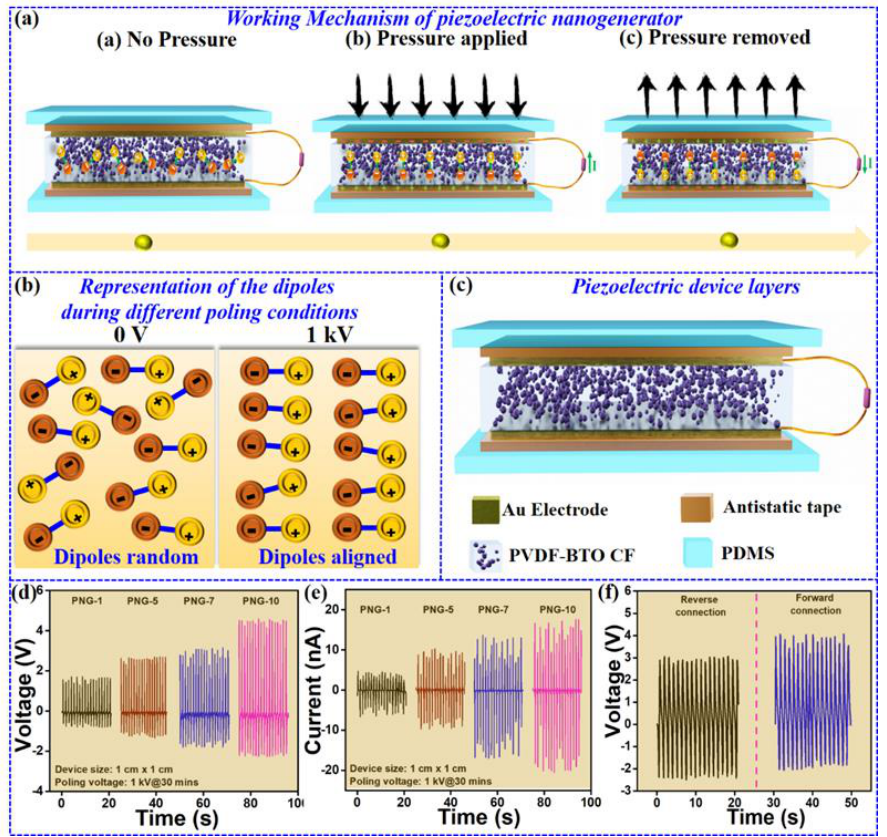
Figure 3. Experimental for the piezoelectric nanogenerator. ( a ) Working mechanism of the fabricated piezoelectric generator, ( b ) representation of the poling and dipole arrangement on applying different voltage, ( c ) layer by layer schematic of the piezoelectric nanogenerator device, ( d , e ) voltage and current of the piezoelectric nanogenerator of various composition, ( f ) the reverse and forward voltage/switching polarity test of the PNG10 device.